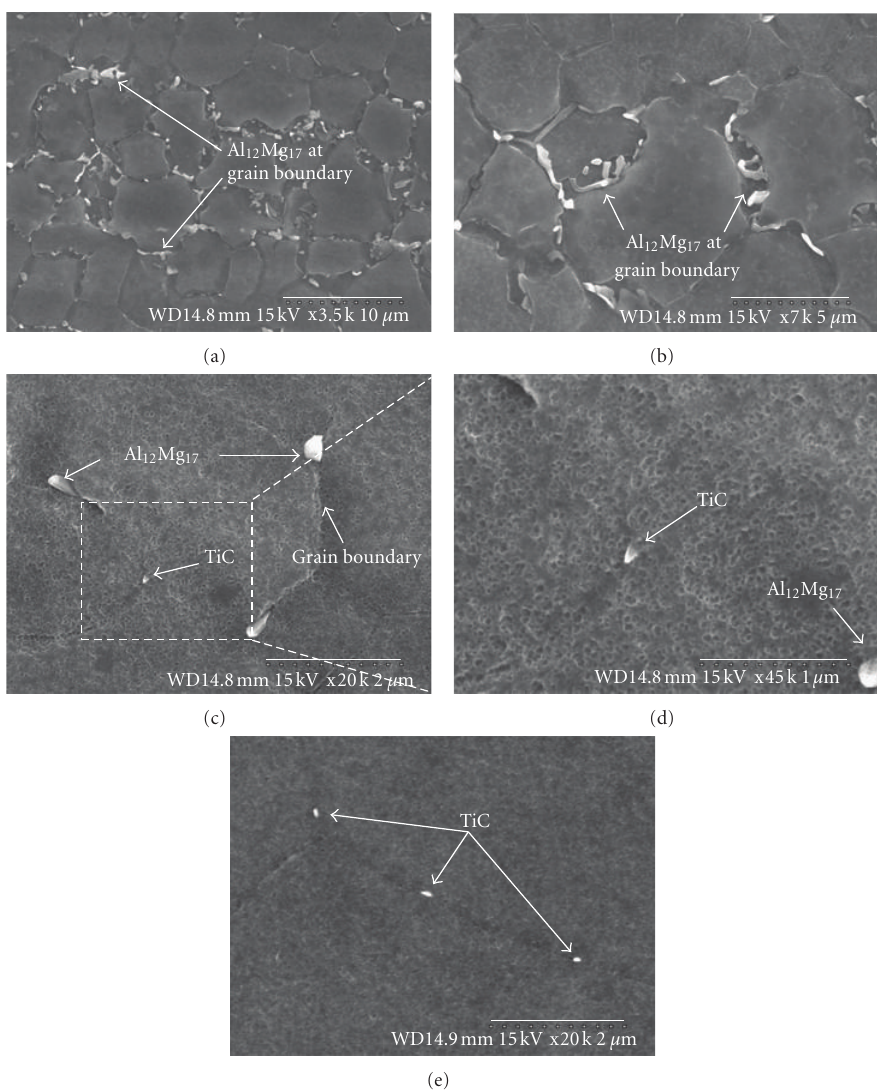
Figure 2: Representative micrographs showing grain size in monolithic AZ31/AZ91 and AZ31/AZ91/TiC nanocomposite: (a) lower magni- fication and (b) higher magnification. (c, d, e) Representative micrographs showing the presence of individual TiC nanoparticles and fine Al 12 Mg 17 intermetallic particles in the AZ31/AZ91/TiC nanocomposite: (c, e) lower magnification and (d) higher magnification.